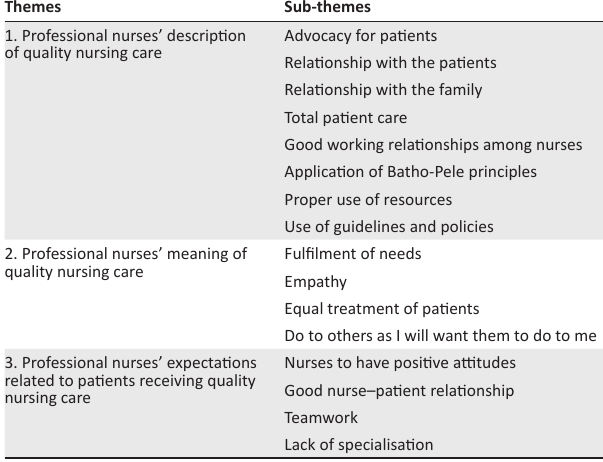
TABLE 2: An outline of the identified themes and sub-themes.